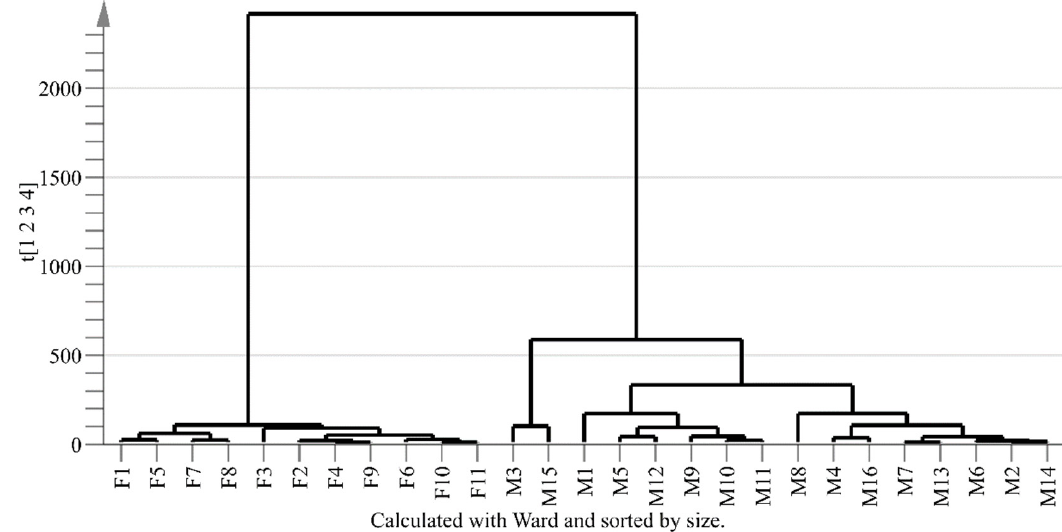
Figure 5. Dendrogram of HCA. F1~F11 refer to the female samples and M1~M16 refer to the male samples. The X axis refers to sample name and Y axis refers to the distances between different groups.